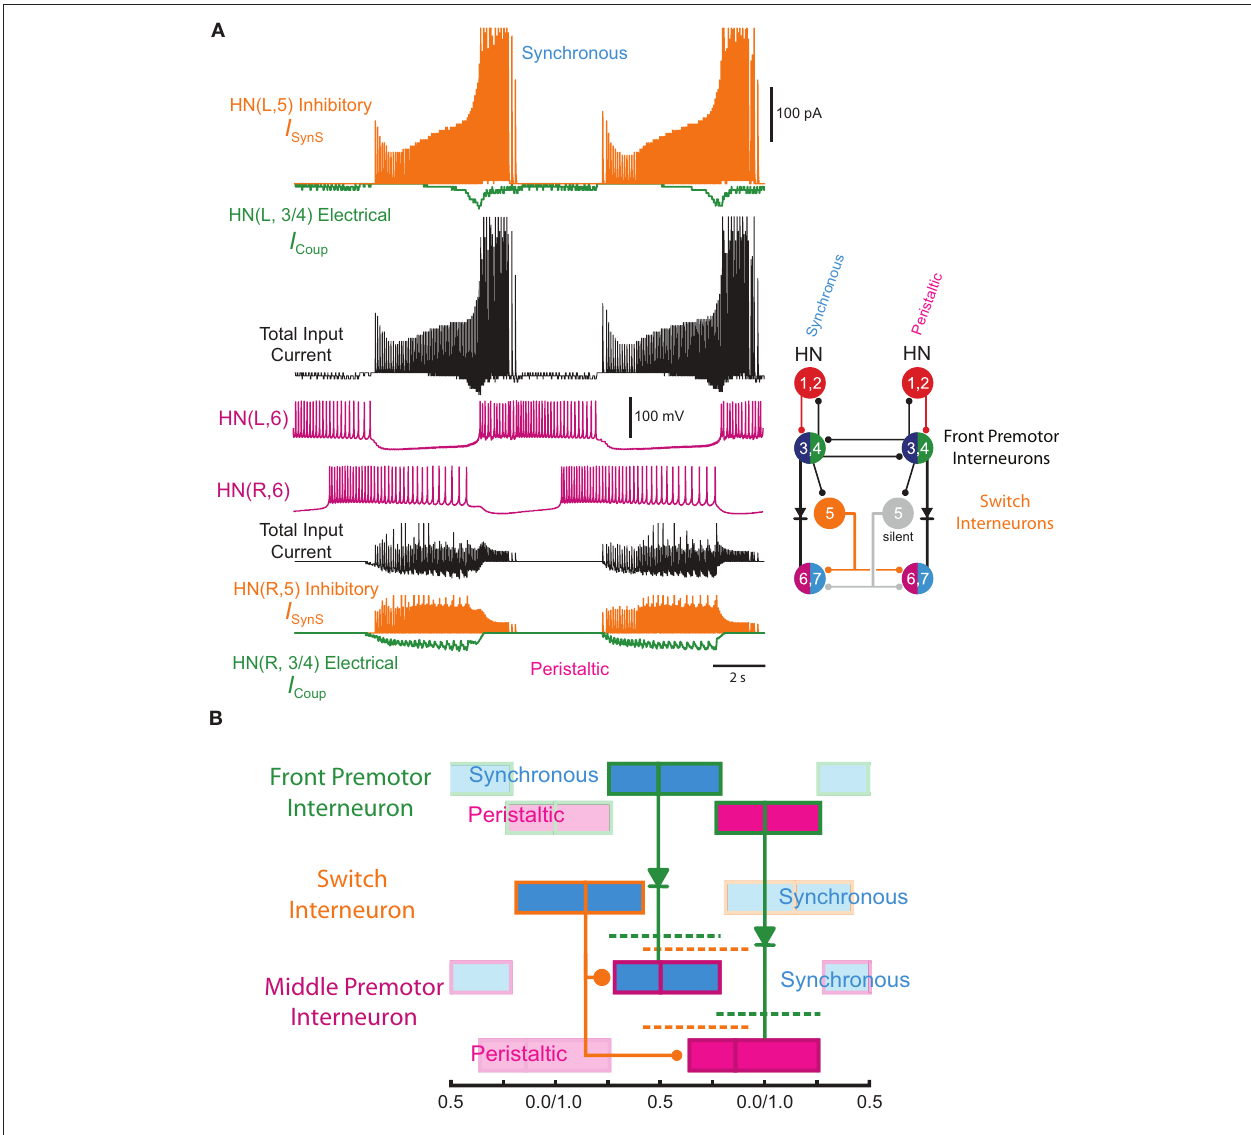
terminates the HN(R, 6) burst, but in the absence of any input the HN(R,6) Figure 4 | exploration of our CPg model. (A) Inhibitory synaptic ( I ) and SynS interneuron recovers and begins to fire approximately midway between input electrical coupling ( I ) current flowing in the HN(6) premotor interneurons, Coup bouts, due to its intrinsic bursting properties. (B) Schema based on a phase synchronous and peristaltic. With the canonical parameter ( g SynS and g Coup ) values diagram that illustrates how the appropriate phasing of the middle premotor chosen in Figure 3 , the total input current (black) to the synchronous HN(L,6) interneurons is achieved in the CPG model. To emphasize a single cycle in the interneuron is dominated by the inhibitory synaptic current from the active diagram all but one cycle is made transparent. Box fill color indicates HN(L,5) switch interneurons (orange). The electrical coupling current, I , from Coup coordination mode, synchronous (light blue) and peristaltic (pink) and box the ipsilateral HN(L,3) and HN(L,4) front premotor interneurons (green) brings on boundary colors [green HN(4), orange HN(5), magenta HN(6)] indicate the model firing in the HN(L,6) at the end of the inhibitory current, I , from the switch SynS interneuron. Middle spike phase (“phase”) is indicated by a vertical line in the interneuron but otherwise has little effect. Consequently, the HN(L,6) box, while the first and last spike phases are indicated by the left and right interneuron fires essentially in antiphase with the active HN(L,5) interneuron. boundaries of the box respectively. The dashed lines indicate the expected The total input current (black) to the peristaltic HN(R,6) interneuron is a phasing if the middle premotor interneurons received only inhibitory input (ball compromise between the inhibitory synaptic current, I , from the active SynS scaled for relative strength) from the active switch interneuron (orange) or only HN(L,5) switch interneuron (orange) and the electrical coupling current, I , Coup electrical input (diode) from the front premotor interneurons (green). The from the ipsilateral HN(L,3) and the HN(L,4) premotor interneurons (green) measured phase of both middle premotor interneurons is a combination of because of their extensive temporal overlap. At the end of the electrical coupling these two current from the ipsilateral front premotor interneurons, the inhibitory current